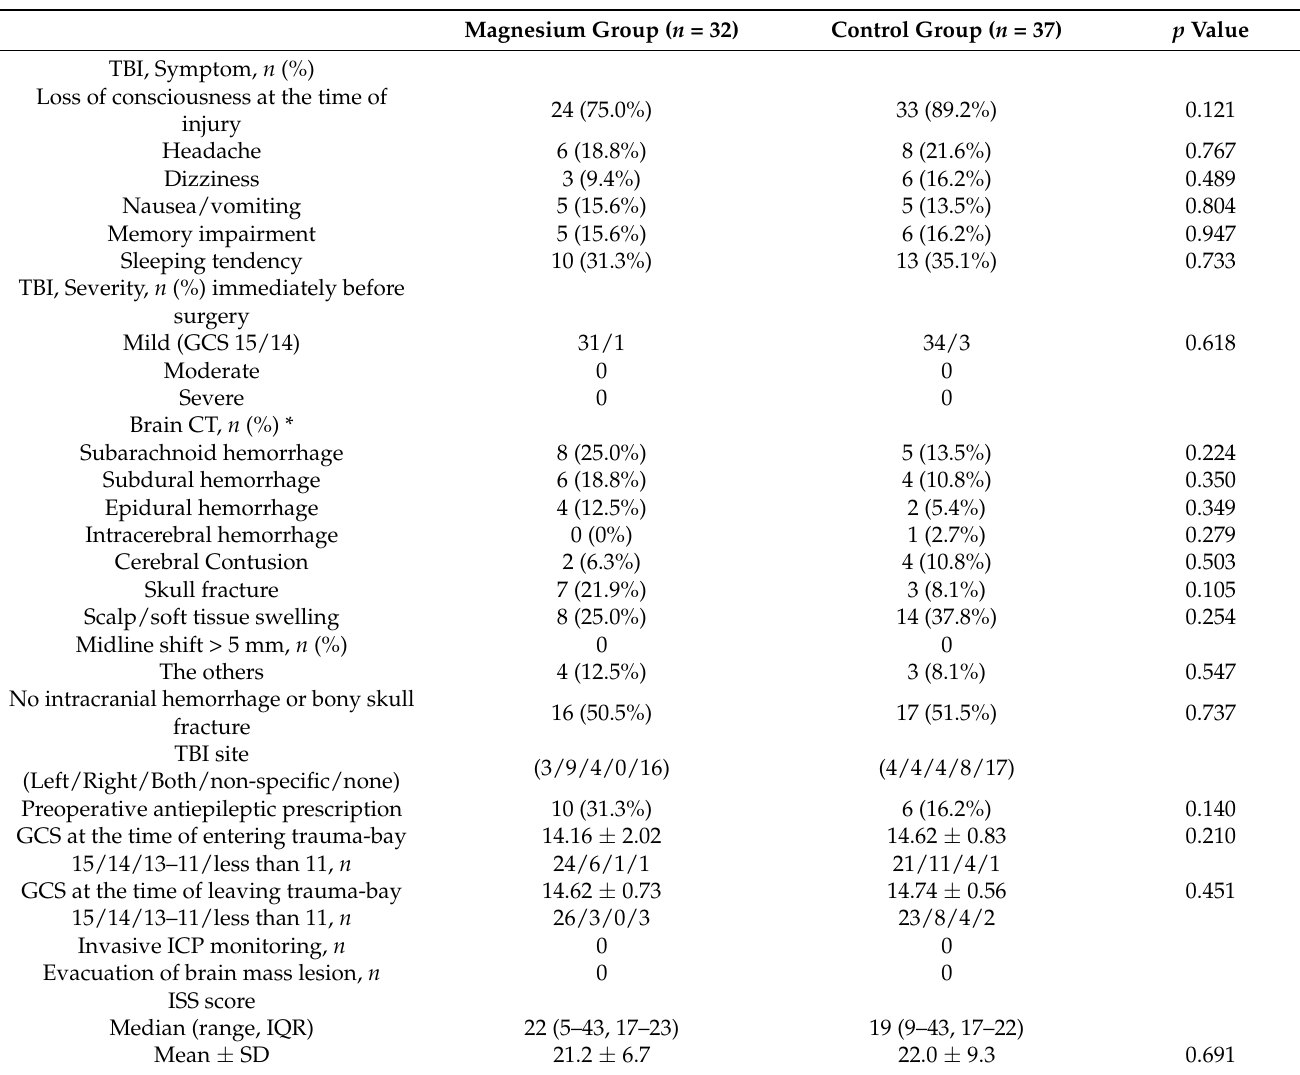
Table 2. Traumatic brain injury aspects